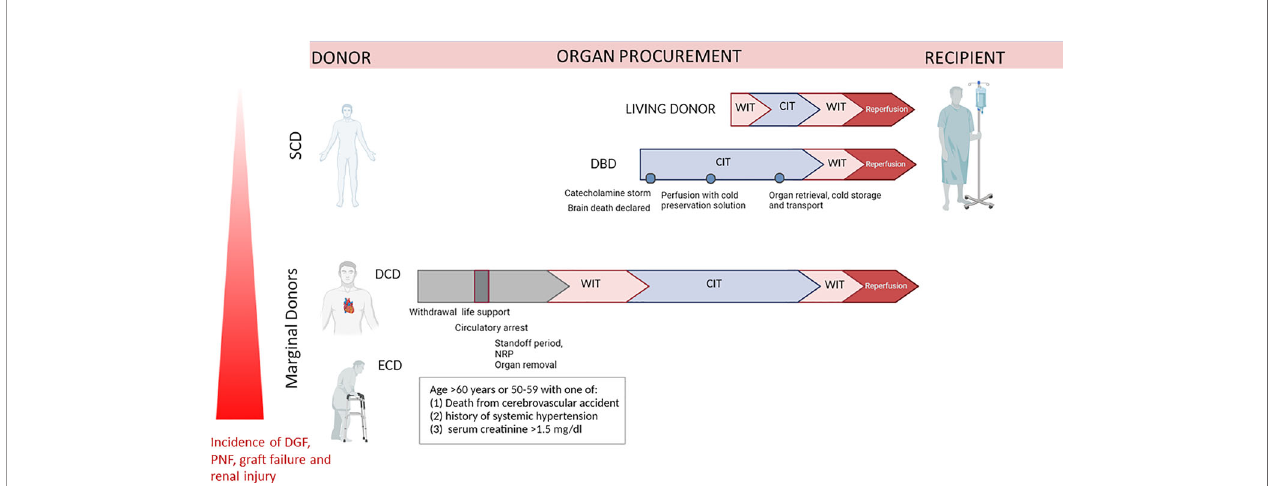
FIGURE 1 | Representation of different ischemia types exposure of organs retrieved from Living Donor (LD), DBD, DCD and ECD. Organ retrieved by DCD and ECD, or DCD+ECD donors are subjected to longer warm ischemia time due to cardiocirculatory arrest, whereas in DBD surgical preparation and perfusion with cold preservation solution is initiated immediately after cerebral death. DCD, donation after circulatory death; DBD, donation after brain death; ECD, Expanded criteria donors; WIT, warm ischemia time; CIT, cold ischemia time; SCD, Standard Criteria